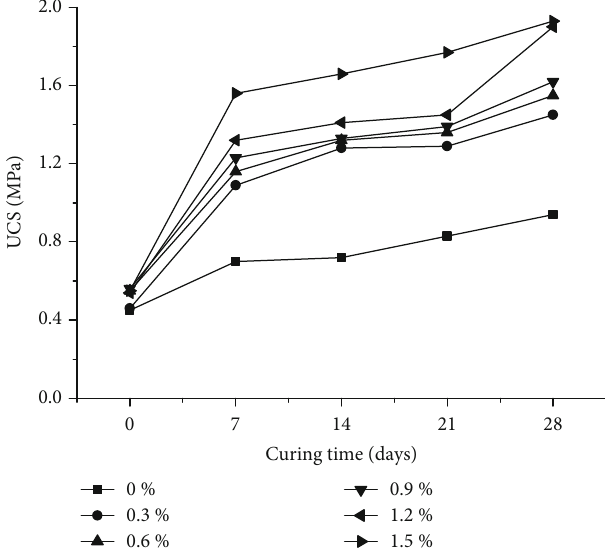
Figure 6: E ff ect of the curing time on the UCS for di ff erent ZM concentrations.